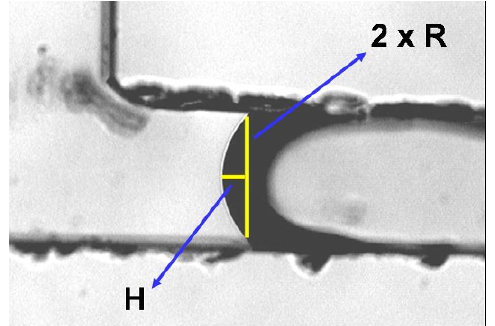
Figure 6. Contact angle measurement in